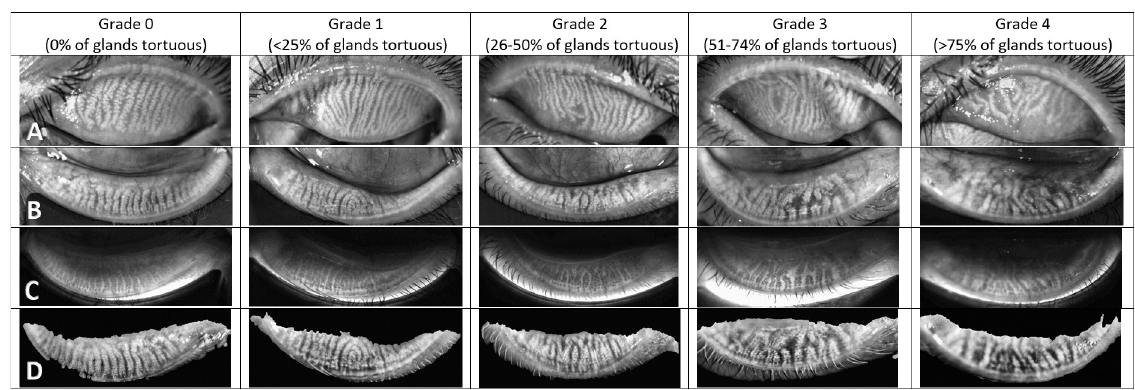
Fig 2. The Meibomian gland tortuosity grading system. Row A: Dynamic illumination mode (Reflect infrared) of upper lids; Row B: Dynamic illumination mode (Reflect infrared) of lower lids; Row C: Adaptive transillumination mode (Trans infrared) of lower lids; Row D: Dual mode (combine dynamic illumination and adaptive transillumination) of lower lids.